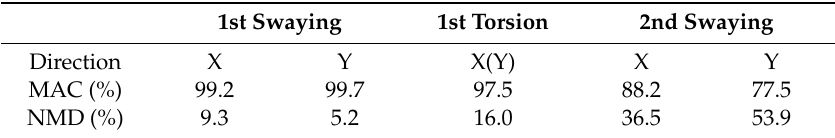
Table 7. Values of modal assurance criterion (MAC) and normalized modal di ff erence (NMD) between measured and simulated mode